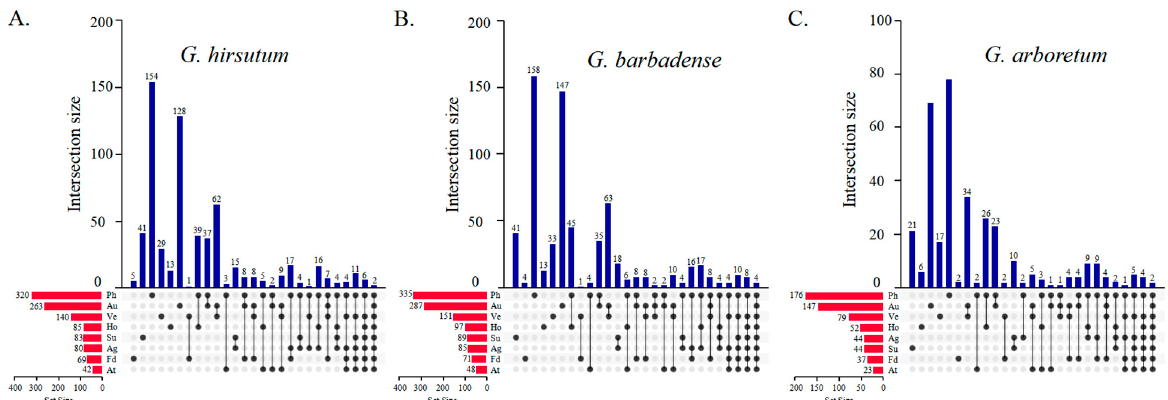
Figure 1. Identification and classification of flowering-related genes in G. hirsutum , G. barbadense , and G. arboretum . ( A ) G. hirsutum . ( B ) G. barbadense . ( C ) G. arboretum . The histogram on the left represents the number of flowering-related genes of each flowering-regulated pathway, a single black point in the middle matrix represents the number of genes specific to a pathway, the lines between the black points represent the intersection of the different pathways, and the vertical blue histogram represents the corresponding intersecting gene numbers. Ph: photoperiodism pathway; Au: autonomous pathway; Ho: hormone pathway; Ve: vernalization; Ag: aging pathway; Su: sugar signal; Fd: flower development and apical meristem response pathway; At: ambient temperature pathway.